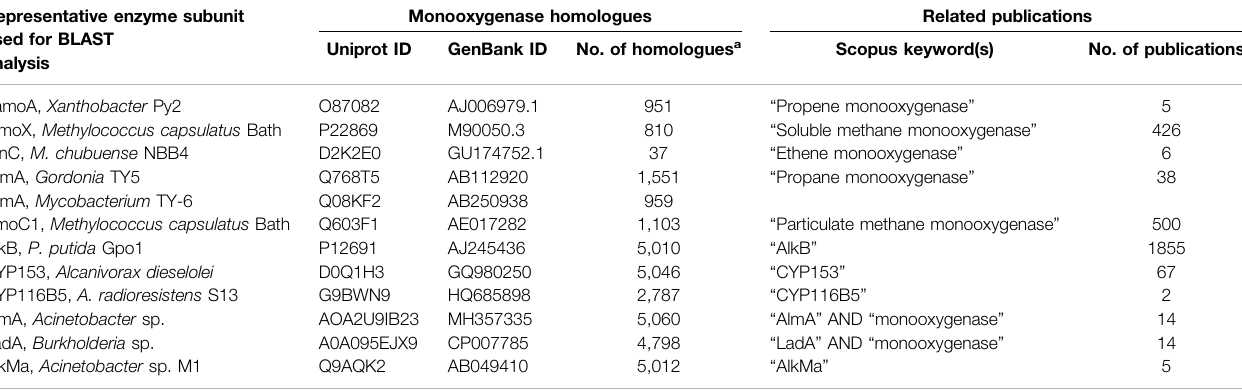
TABLE 2 | Classi fi cation and quanti fi cation of monooxygenase homologues and related publications in public databases. Representative enzyme subunit used for